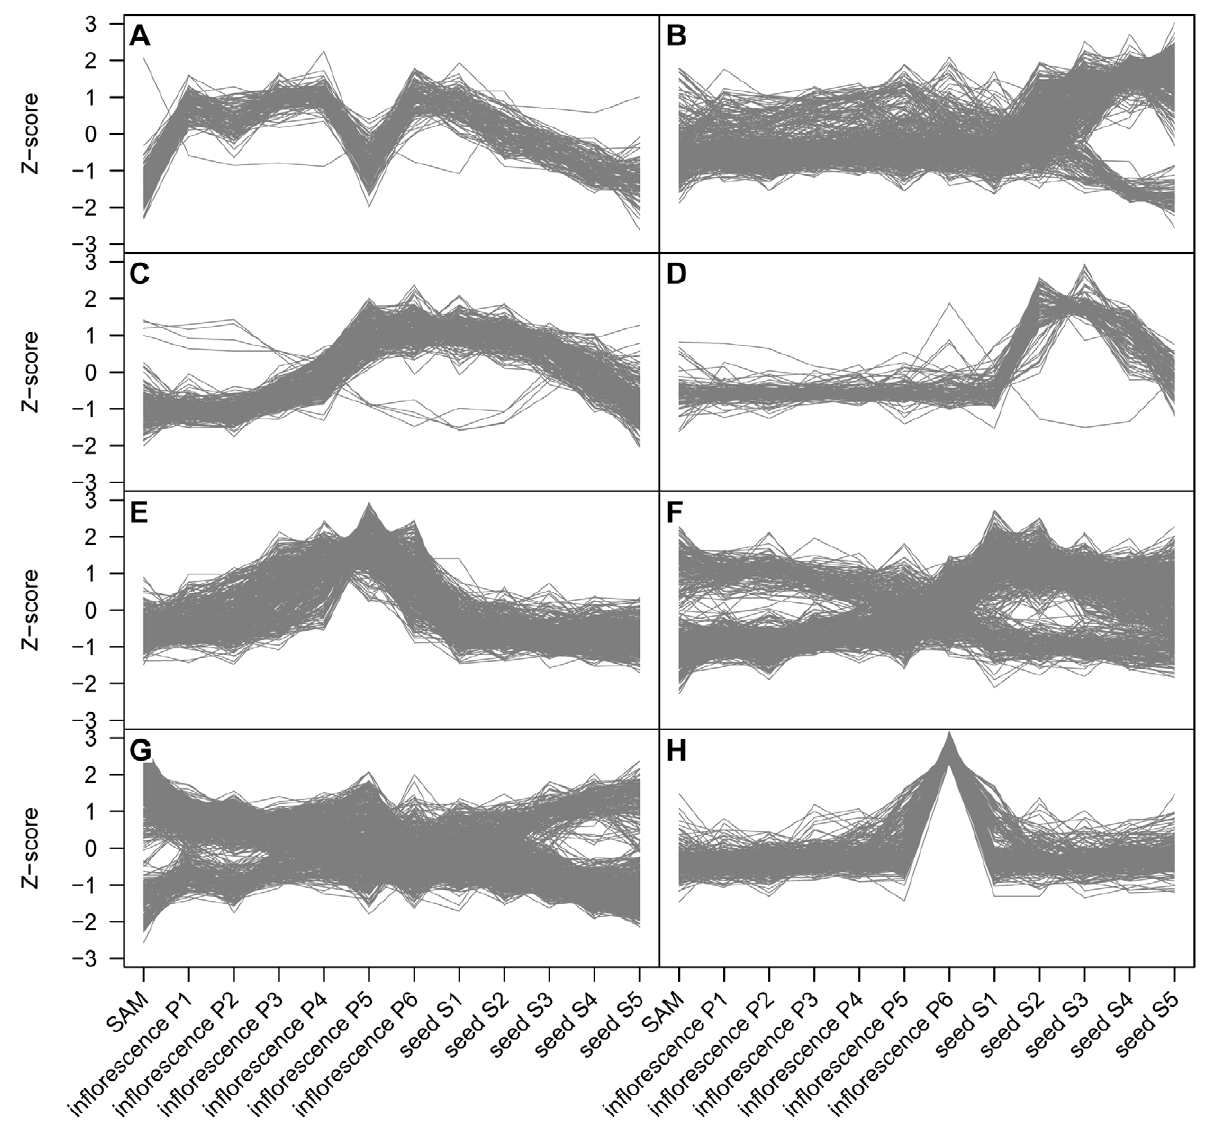
Figure 1. Normalized expression values of modules of genes identified from a panicle/seed developmental series. Gene expression values from a panicle and seed developmental series were processed using Weighted Gene Coexpression Network Analysis to identify modules of highly correlated genes [36,42]. Tissues analyzed were shoot apical meristems (SAM), panicles between 0 and 3 cm long (inflorescence P1), panicles between 3 and 5 cm long (inflorescence P2), panicles between 5 and 10 cm long (inflorescence P3), panicles between 10 and 15 cm long (inflorescence P4), panicles between 15 and 20 cm long (inflorescence P5), between 22 and 30 cm long - mature pollen stage (P6), developing seed 0 to 2 days after pollination (dap; seed S1), developing seed 3 to 4 dap (seed S2), developing seed 5 to 10 dap (seed S3), developing seed 11 to 20 dap (seed S4), developing seed 21 to 29 dap (seed S5). Expression data are represented here as normalized values (Z-scores). Modules names: (A) GSE6893-black, (B) GSE6893-blue, (C) GSE6893-red, (D) GSE6893-pink, (E) GSE6893-yellow, (F) GSE6893-brown, (G) GSE6893-turquoise, (H) GSE6893- green.